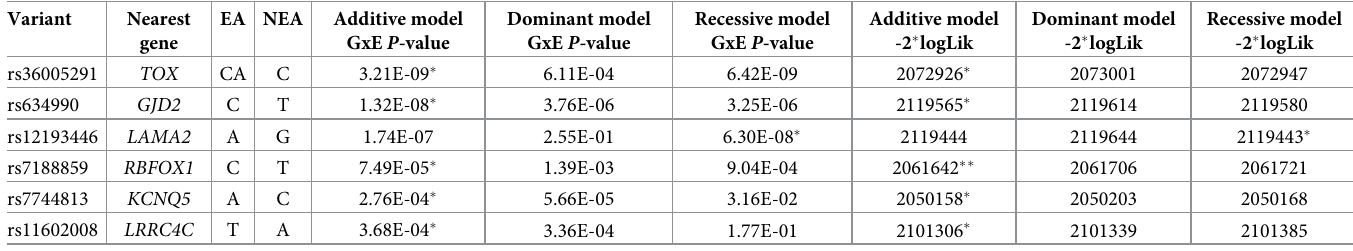
Table 4. Tests for genotype-by-education interaction when allowing for dominance effects. Linear regression analyses were performed for the AOSW phenotype in the Stage-II sample for genotype-by- UniEdu interactions when the SNP effect allele was coded as additive (0, 1 2), fully dominant (0, 1, 1) or fully recessive (0, 0, 1). The effect allele is the allele associated with a more myopic refractive error in a linear regression test for an additive marginal effect of the variant.